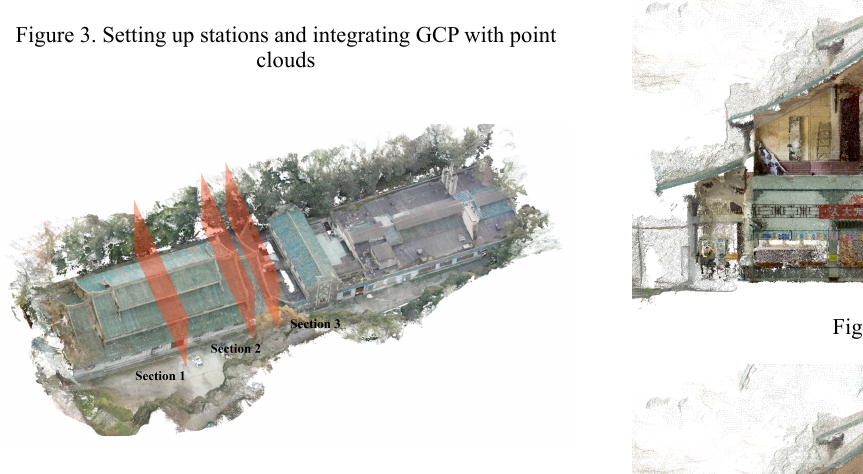
Figure 4. The final registered model allowing random slices for